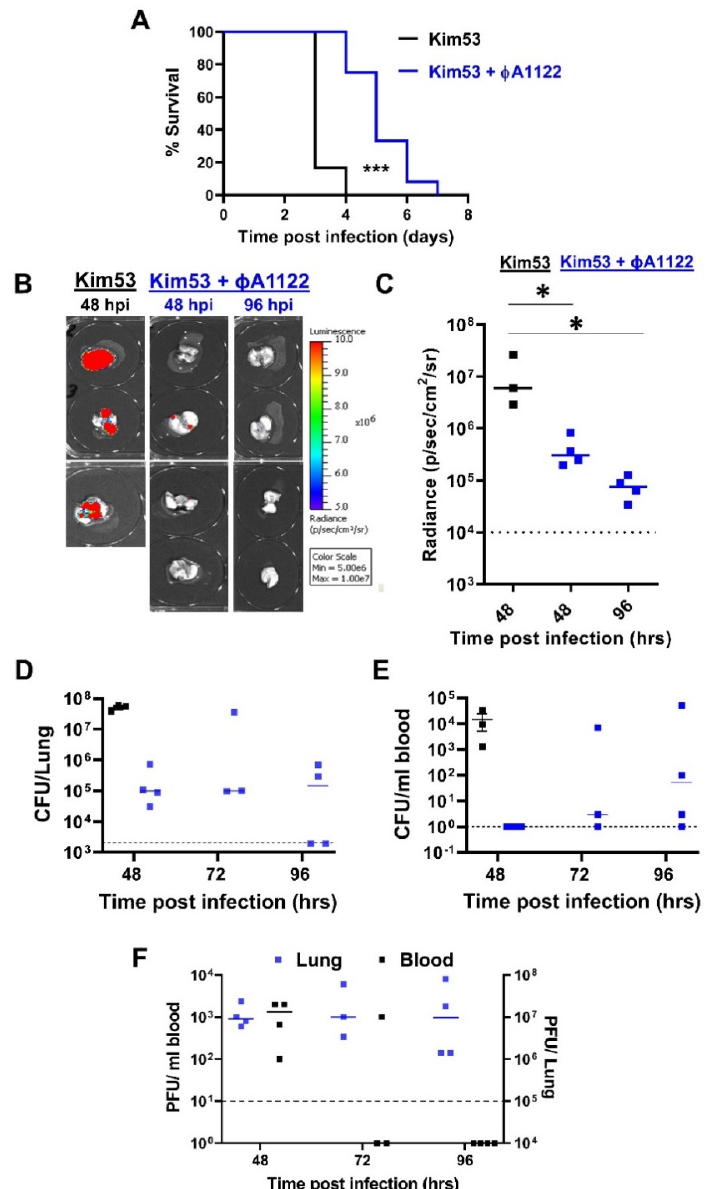
Figure 2. Intranasal administration of a single phage dose delayed disease progression. C57BL/6J mice were intranasally infected with 10 × LD 50 Y. pestis Kim53 strain ( A ) or Kim53-lux luminescent strain ( B – F ). For phage treatment, one dose of 1 × 10 9 ф A1122 PFU/mouse was IN administered at 5 hpi. Control mice were subjected to intranasal administration of PBS. (A) Survival curves of control mice (black line, n = 6) and phage-treated mice (blue line, n = 12). ( B , C ) Control (n = 3) and phage- treated mice (n = 4) were anesthetized at the indicated time points post Y. pestis infection. Lungs were harvested, and imaging was performed using IVIS as detailed in the Section 2. ( D , E ) The bacterial load in the lungs and blood was quantified by plating serial dilutions of tissue homogenate/blood on BHIA plates supplemented with 200 µ g/mL ampicillin and counting the colonies. Black squares represent nontreated control mice and blue squares represent phage-treated mice. ( F ) Phage titration was performed by the spot assay technique described in the Section 2. Each point represents the phage load in the lungs (blue squares, total PFU/lung) or blood (black squares, PFU/mL) of an individual mouse. Horizontal bars represent median values. Dotted lines mark the limit of detection. Statistically significant differences between groups are denoted by asterisks (* p < 0.05; *** p < 0.0001; log-rank (Mantel–Cox) test). Bars indicate standard errors of the